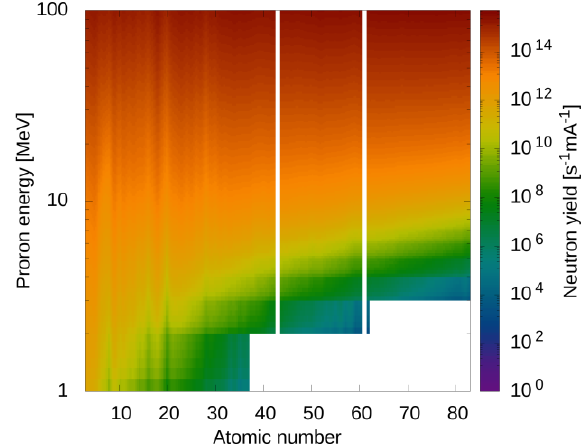
Figure 4: Deuteron induced neutron yield for various target materials determined from the cross sections calculated with the TALYS nuclear code [13] and the stopping powers calculated with the SRIM 2013 toolkit